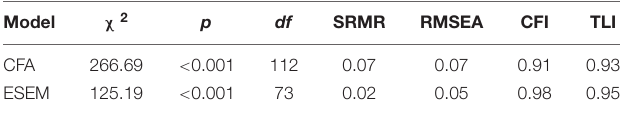
TABLE 1 | CFA and ESEM model fit indices for the expectancy-value motivation scale.